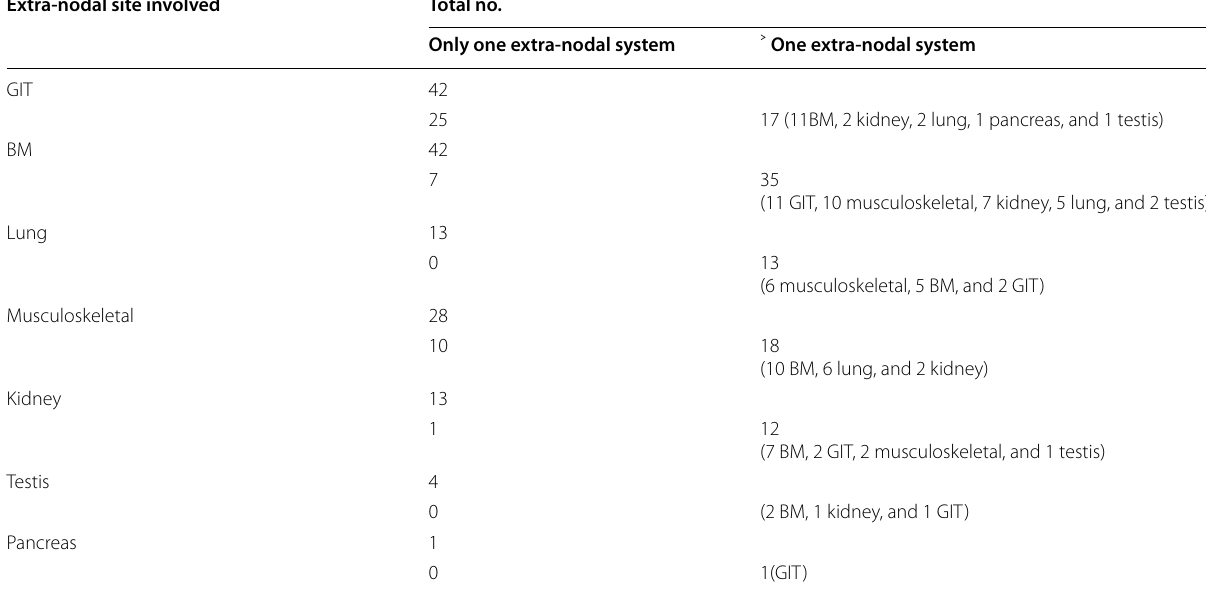
Table 3 Extra‑nodal involved lymphoma sites in our study group Extra-nodal site involved Total